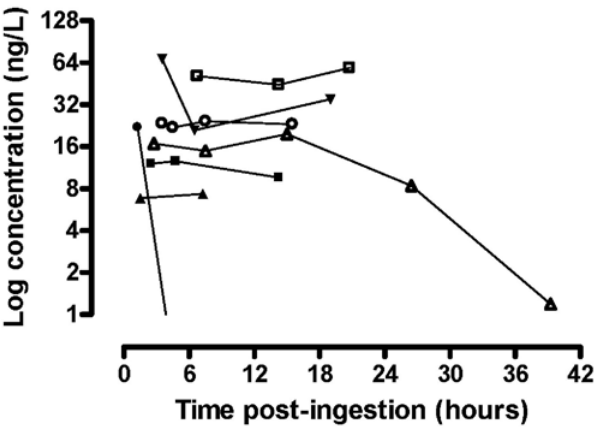
Figure 3. The toxicokinetics of imidacloprid in patients with self-poisoning (n=8 patients). The concentration was high on admission and remained elevated in the majority of patients suggesting either prolonged absorption and/or